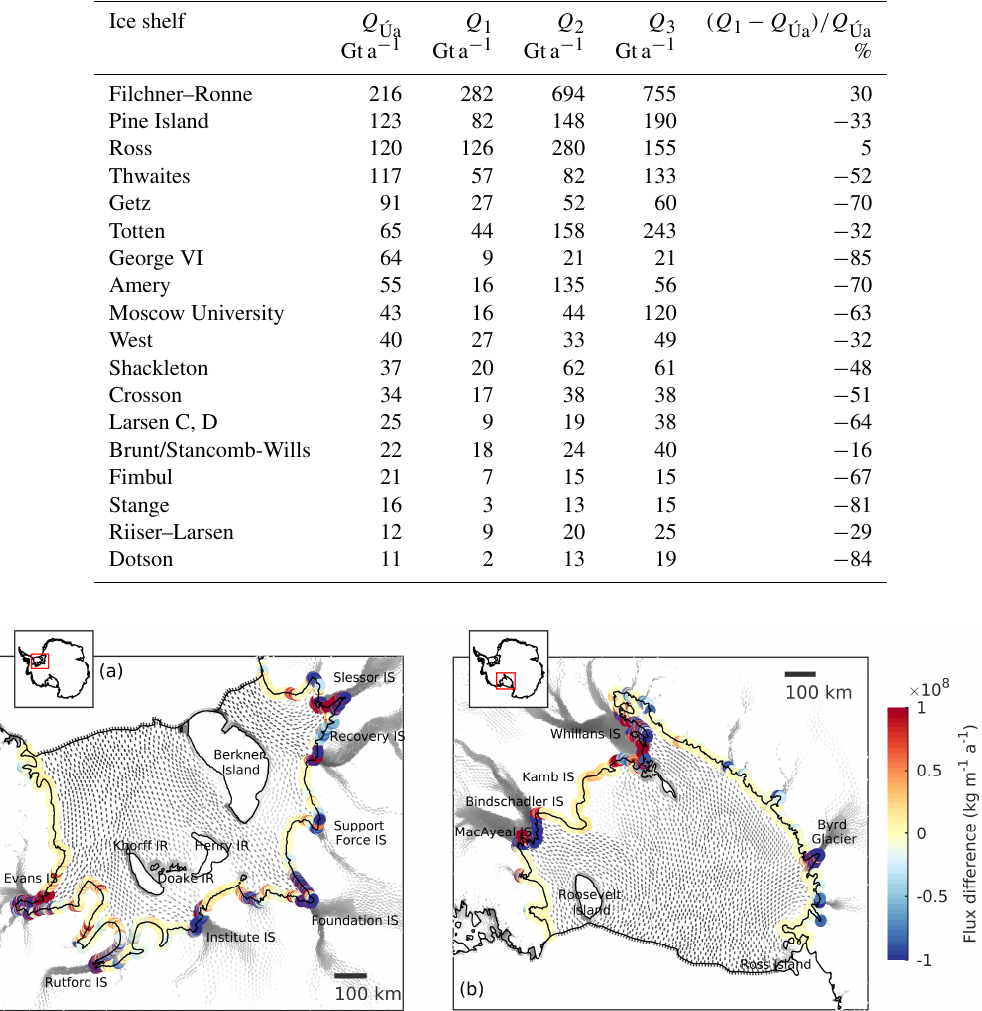
Table 1. Ice flux integrated along the grounding lines of Antarctic ice shelves. Q denotes the modelled ice flux with Úa, Q 1 was derived Úa from the analytical flux formula based on θ 1 , Q 2 based on θ 2 and Q 3 based on θ 3 , respectively. The last column shows the deviation of the analytical flux Q 1 from the modelled Q . Úa